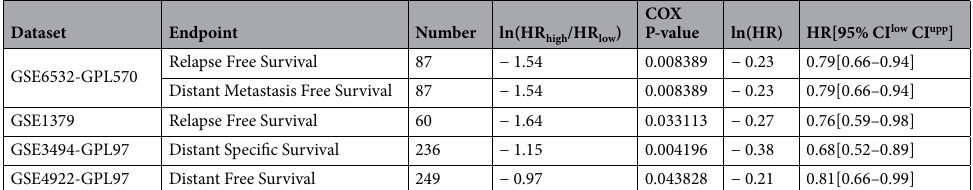
Table 2. Survival analysis of NTN4 mRNA in breast cancer patients (the